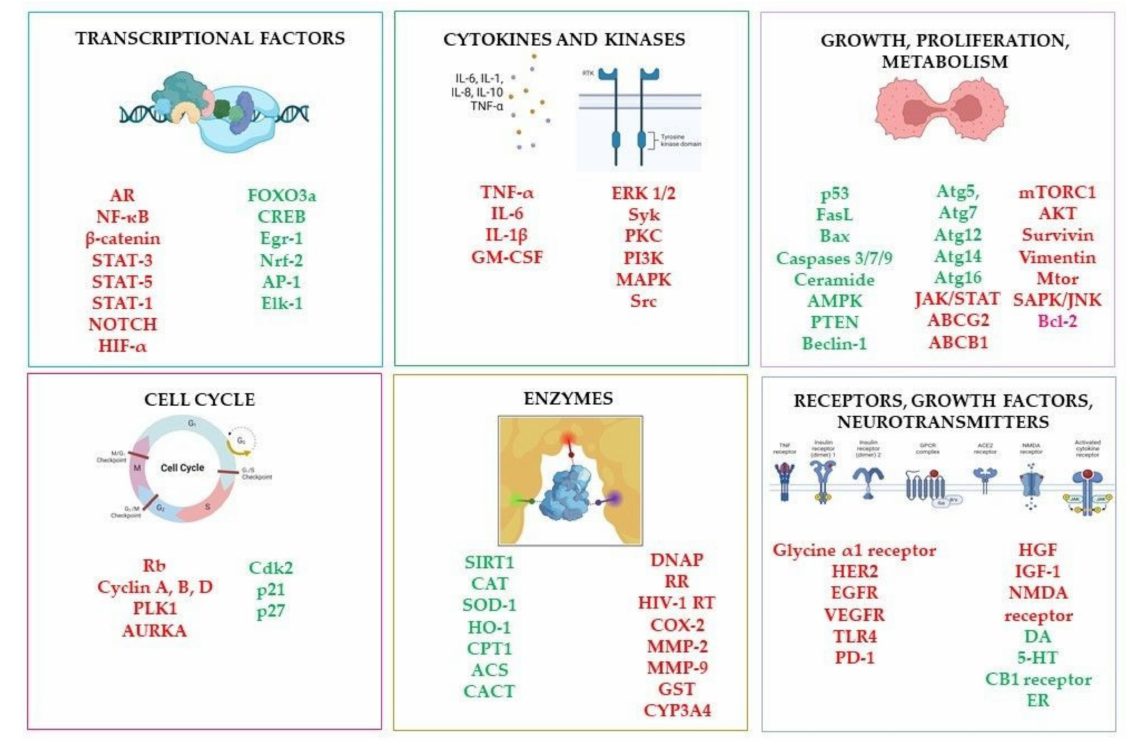
Figure 4. The selected molecular targets of resveratrol. The activated targets are marked in green, while the inhibited ones are in red. Created with BioRender.com. Abbreviations: AR—androgen